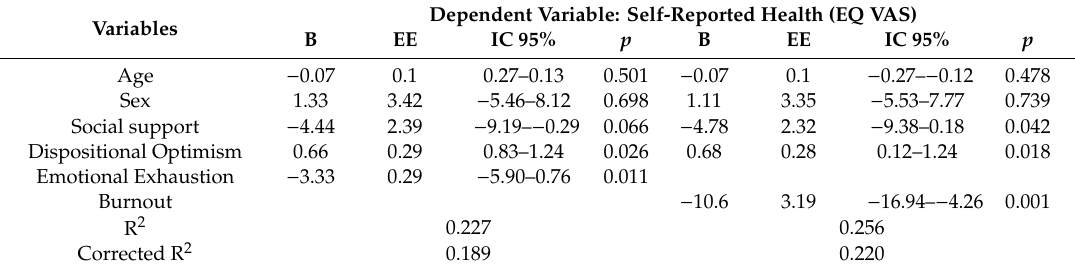
Table 4. Lineal regression models for self-reported health, dispositional optimism and burnout ( n = 109).